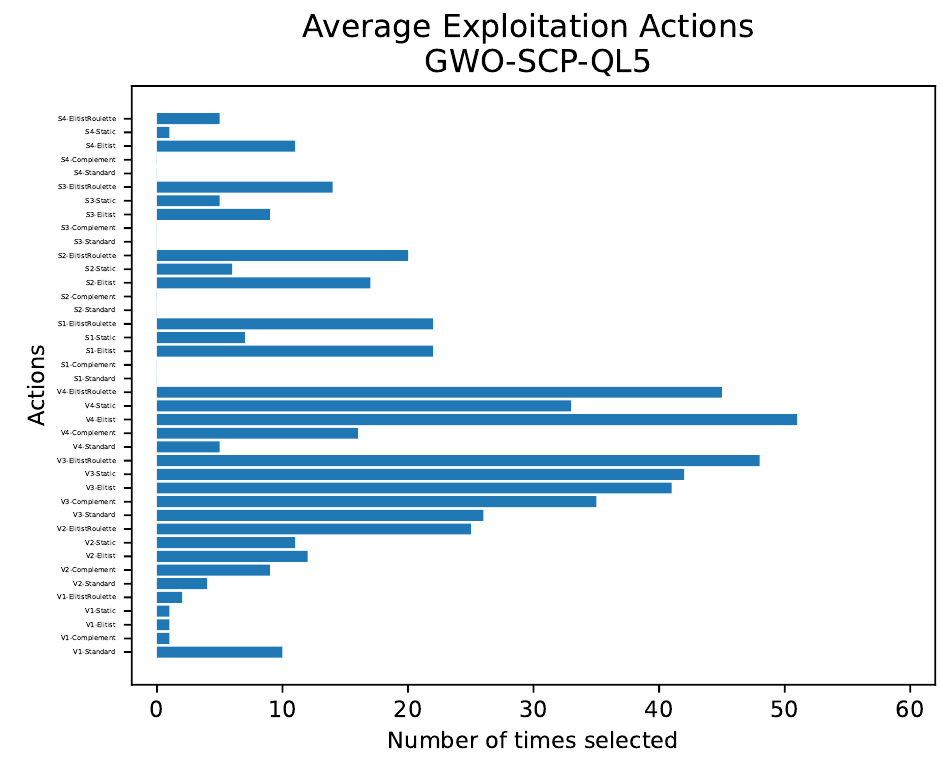
Figure 10. GWO-QL5—The average number of actions in the exploitation state.